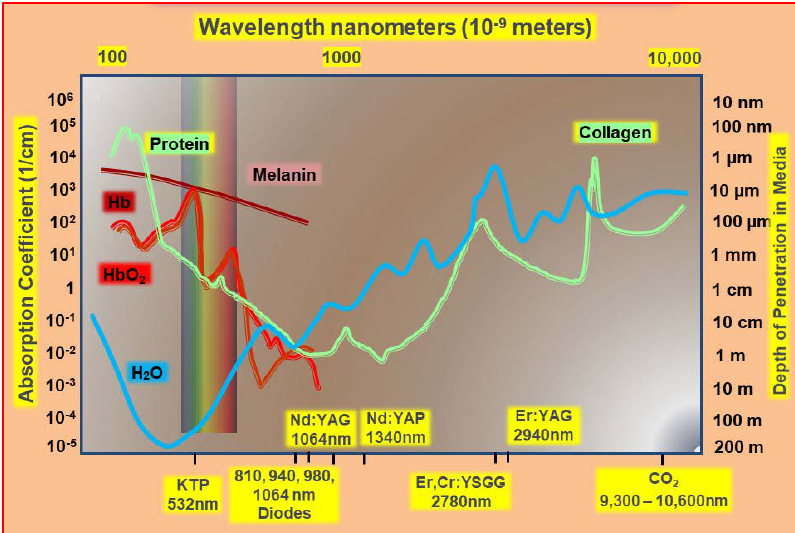
Figure 2. Absorption spectral profiles of major dental / oral structural elements and chromophores associated with soft tissue management. Absorbance is shown relative to wavelength of irradiation.